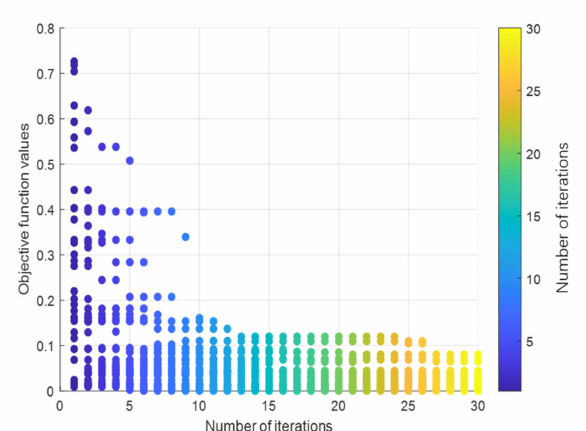
Figure 15. The objective function value of each